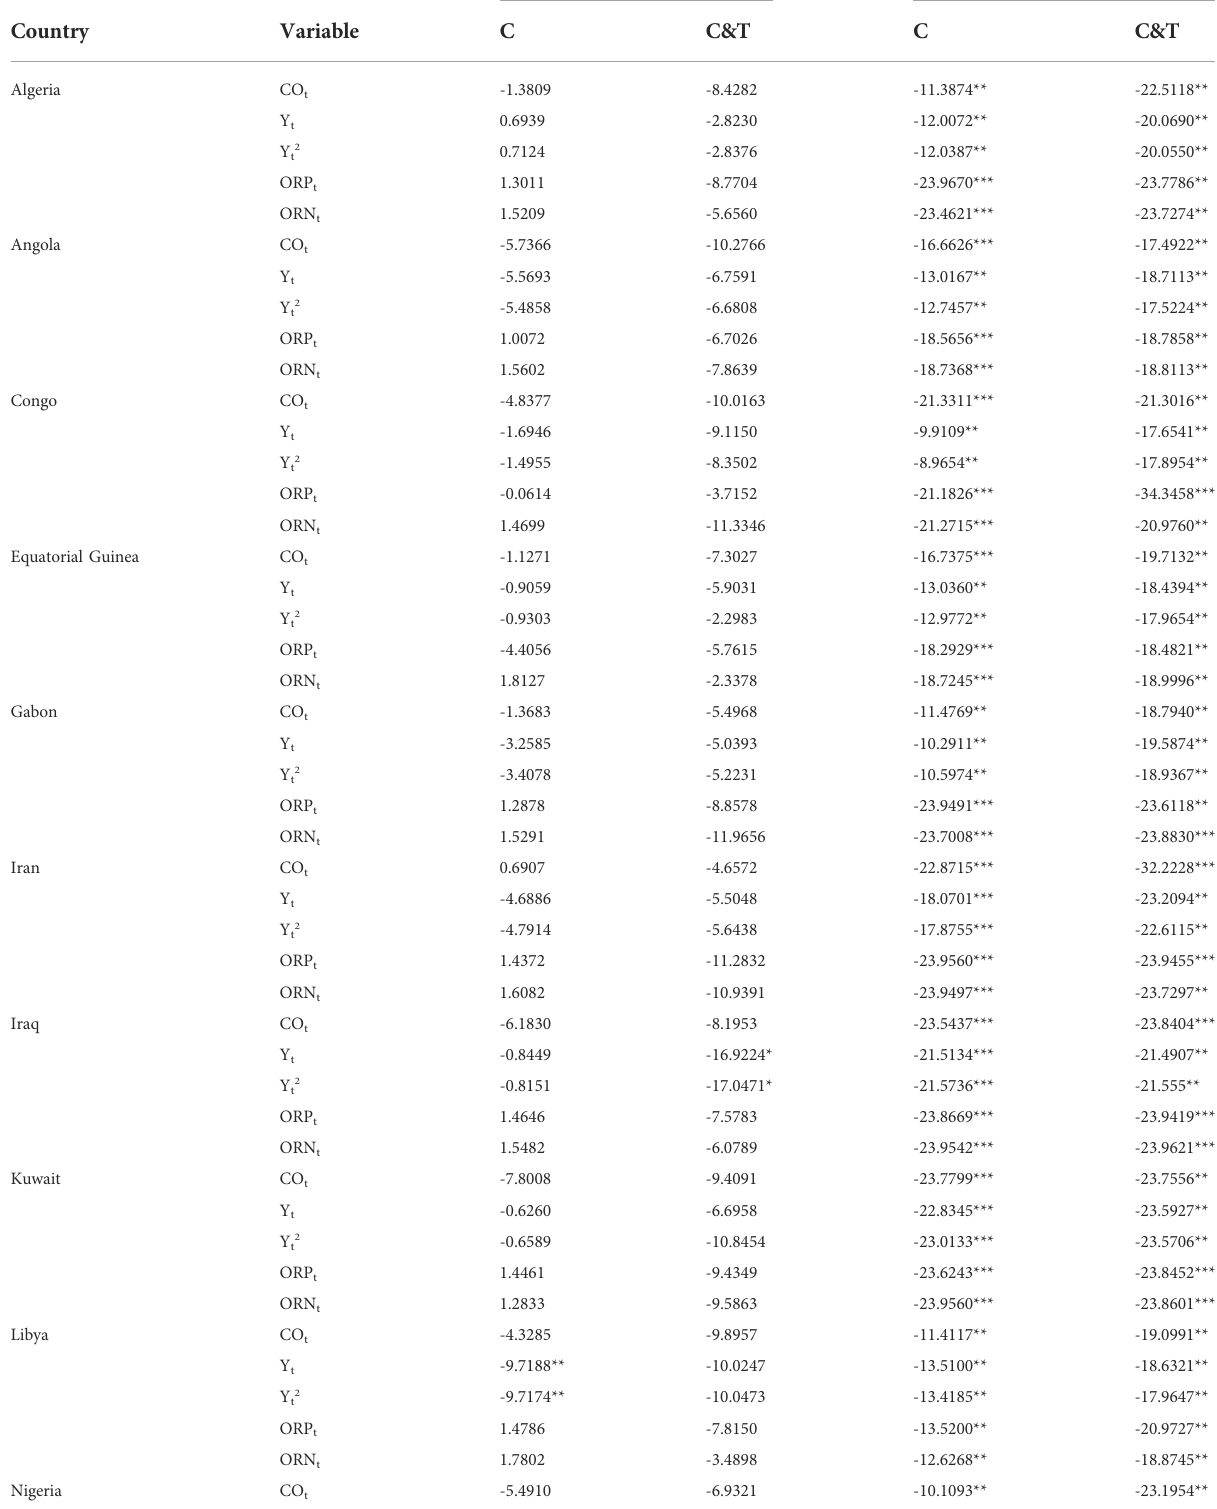
TABLE 1 Ng and Perron Test with MZa